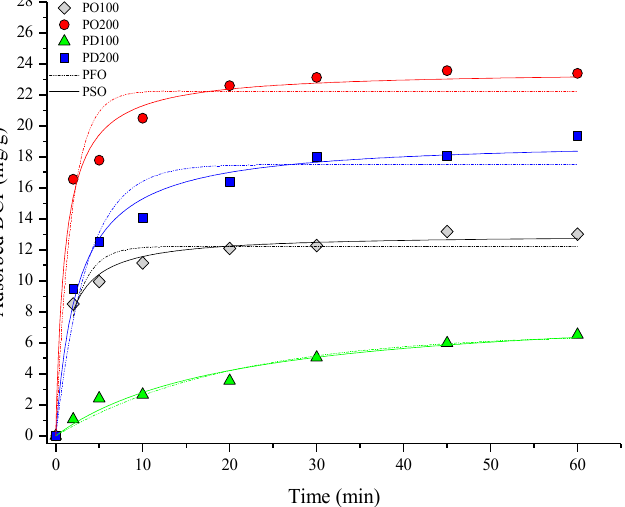
Figure 4. Kinetics run for DCF adsorption on composites of P. PFO = pseudo-first-order; PSO = pseudo-second-order.